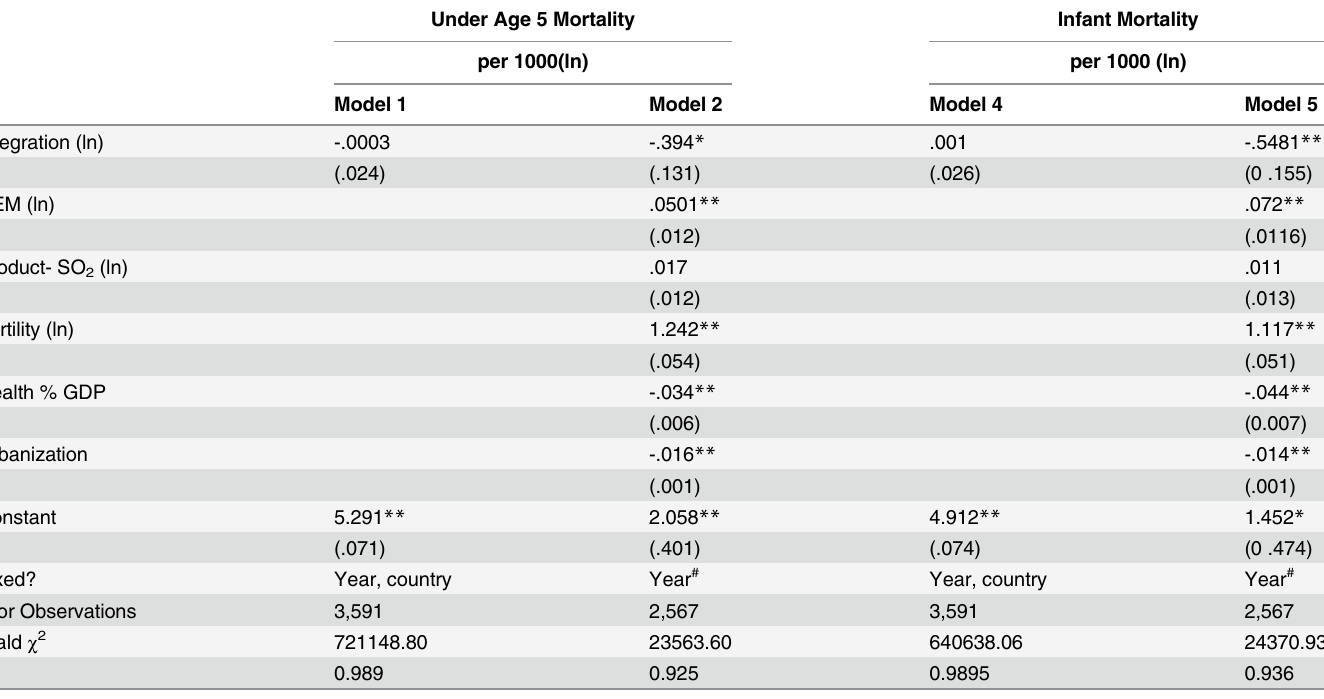
Table 4. Integration Predicting Infant and Child Mortality.